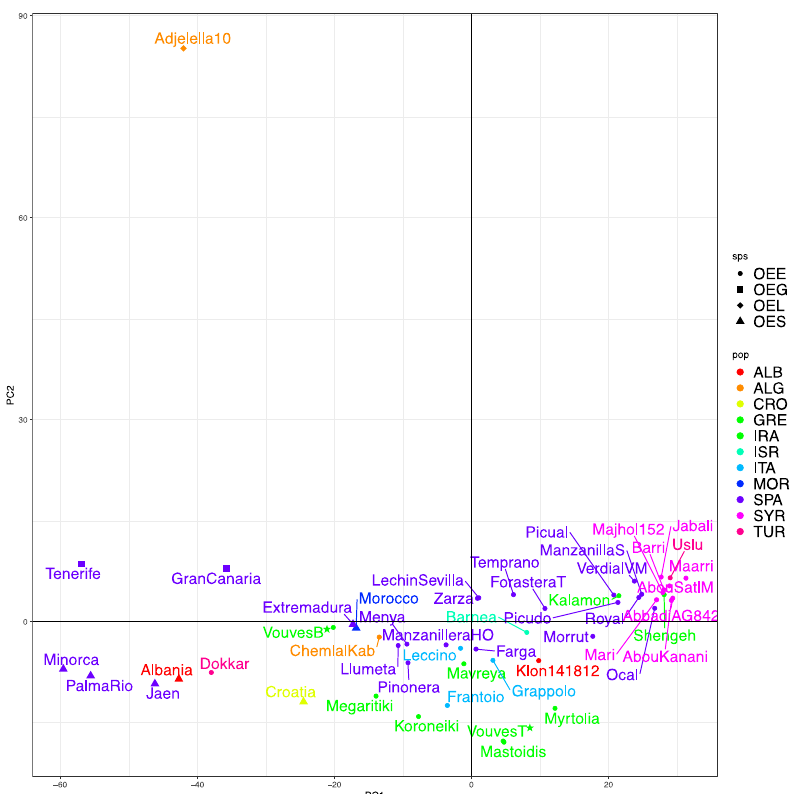
Figure 3. Principal Component Analysis (PCA) of the distance matrix of the different varieties used in this study. PC1 represents 18.77% of the variance and PC2 5.46%. Subspecies is encoded with the shape of the point (OEL, a diamond, for Olea europaea subsp. laperrinei ; OEG, a square, Olea europaea subsp. guanchica ; OES, a triangle, Olea europaea var. sylvestris and OEE, a circle, Olea europaea subsp. europaea ) while country of origin is encoded with different colors (ALB (red), Albania; ALG (orange), Algeria; CRO (yellow), Croatia; GRE (light green), Greece; IRA (green), Iran; ISR (green-blue), Israel; ITA (light blue), Italy; MOR (blue), Morocco; SPA (purple), Spain; SYR (light purple), Syria and TUR (pink), Turkey). Samples of interest (Vouves bottom and top) have been marked with a star.